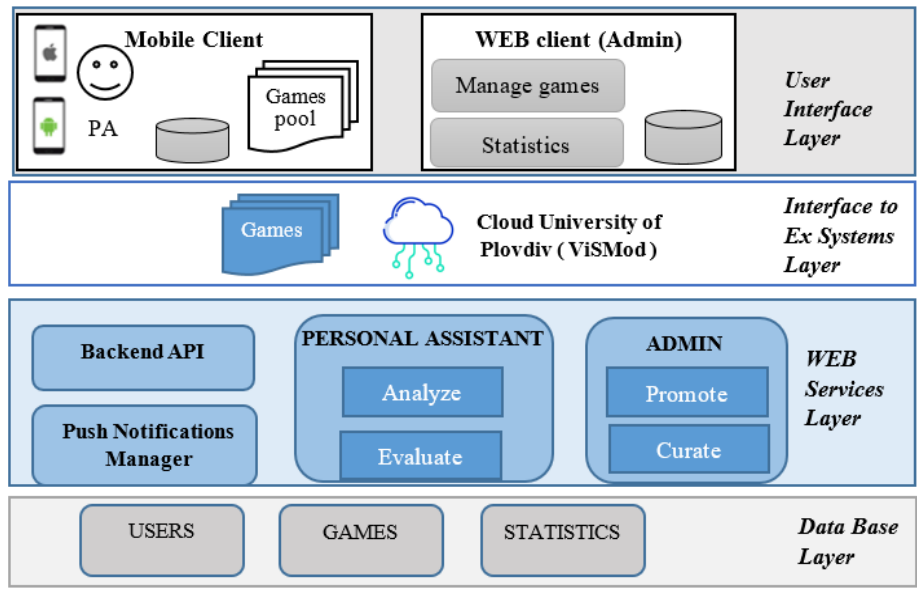
Figure 11. STEM Domain